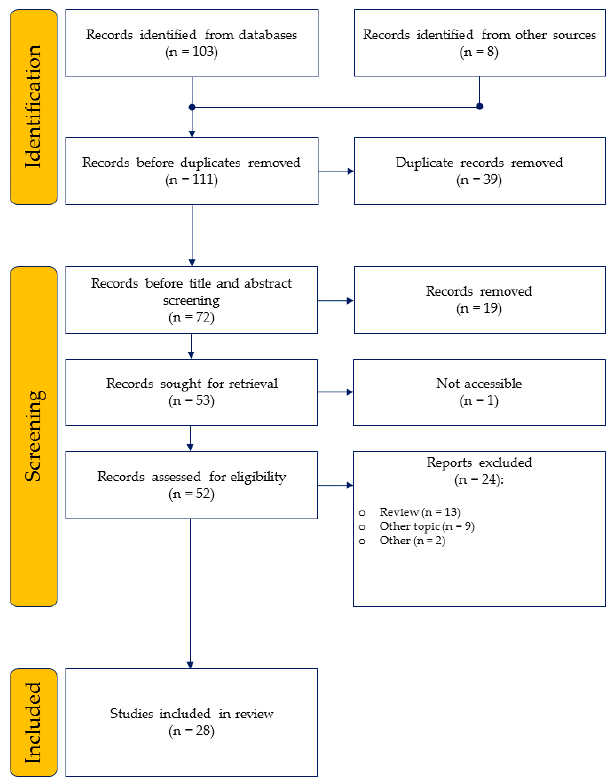
Figure A1. The systematic search process. Source: Authors’ own edition (2022).